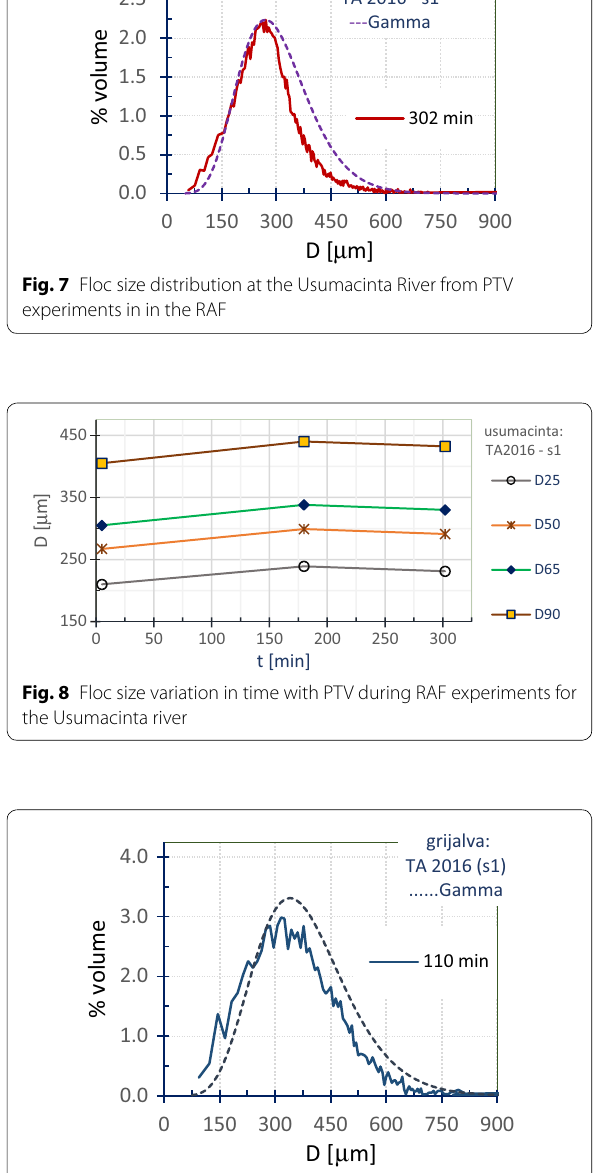
Fig. 9 Floc size distribution at the Grijalva river from PTV experiments in the